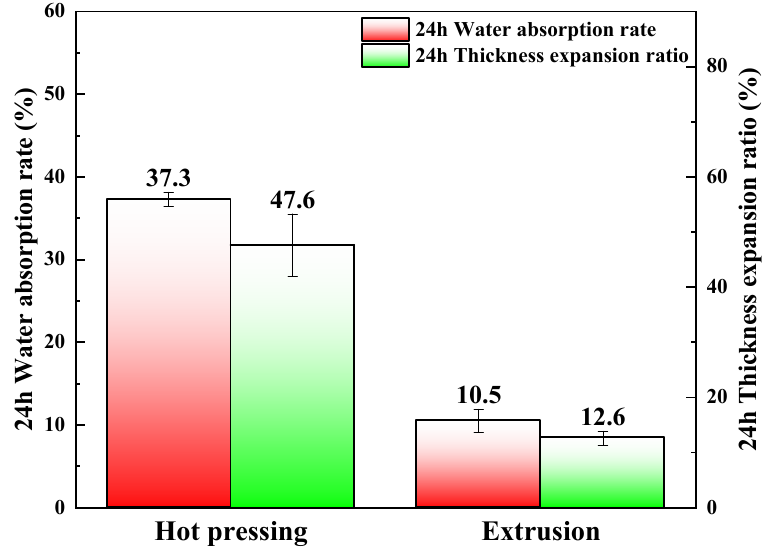
Figure 5. Water absorption mass fractions and thickness expansion ratios of hot pressed and extruded straw/LLDPE composite (immersed for 24 h).